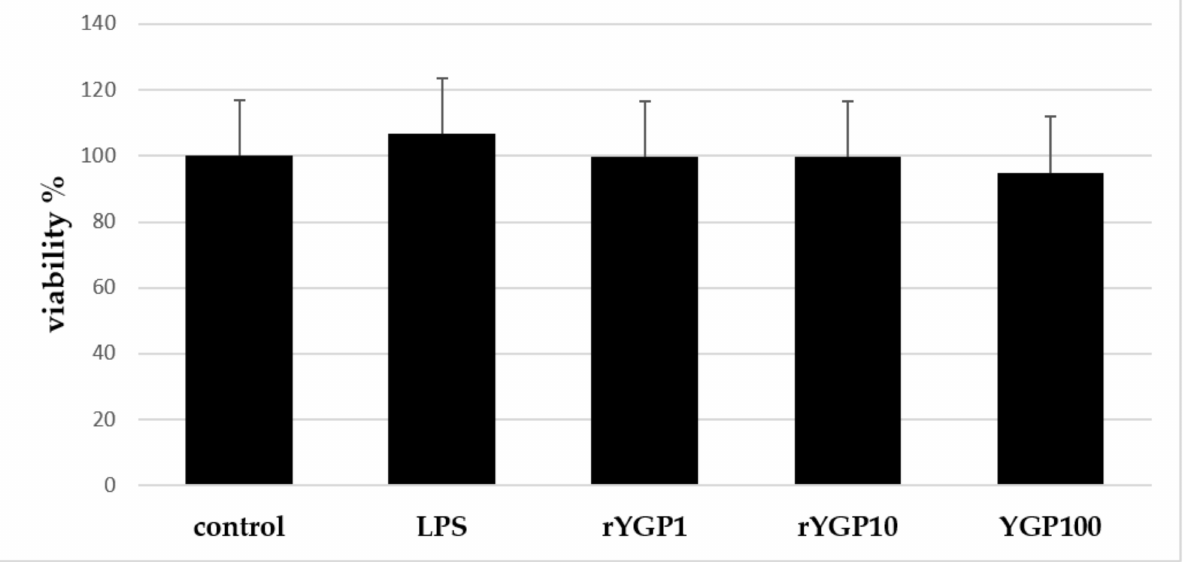
Figure 5. Effect of rYGP40 preparation on viability of bone marrow-derived macrophages of BMDM cell line. BMDM cells (1 × 10 5 /mL) were exposed to rYGP40 at doses of 1, 10, and 100 µ g/mL (rYGP 1, 10, and 100) for 24 h at 37 ◦ C at 5% CO 2 . LPS (1 µ g/mL) was used as a positive inducer. Cell viability was evaluated by MTT assay. The data represent means ± SD of four independent